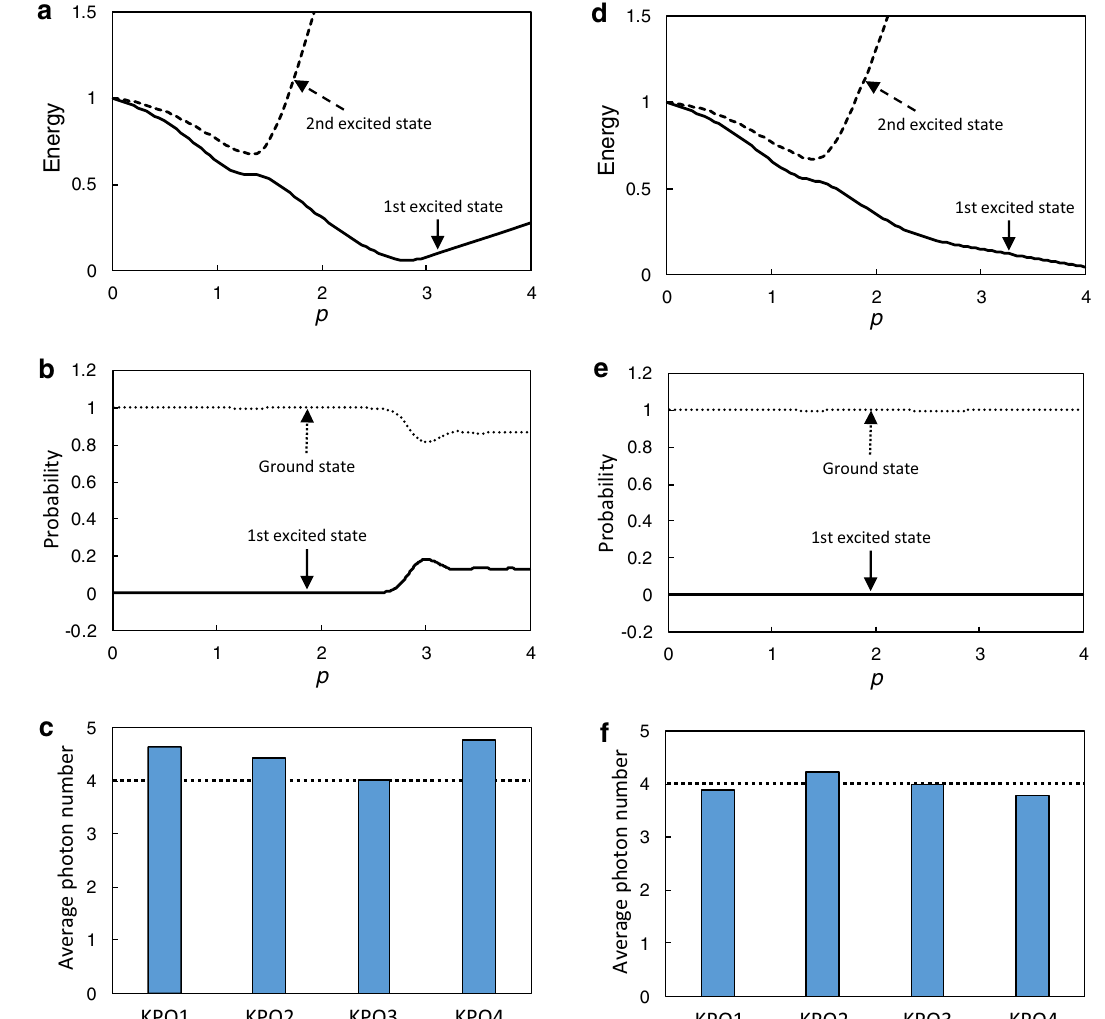
Fig. 5 Characterization of the worst instance of the proposed approach based on excited-state quantum annealing. The instance is indicated by a red vertical arrow in Fig. 1b. a Energy level of the fi rst (solid line) and second (dashed line) excited states from the ground level as a function of pump amplitude p in ground-state quantum annealing (QA) with a network of Kerr-nonlinear parametric oscillators (KPOs). (The reduced Planck constant and the Kerr coef fi cient are set as ℏ = 1 and K = 1, respectively.) b Time evolution of the population of ground (dotted line) and fi rst excited (solid line) states in the ground-state QA. c Final average photon number in each KPO in the ground-state QA. The horizontal dotted line in c indicates our design value 4. d – f Results corresponding to a – c , respectively, when the same instance is solved by ground-state QA with control of individual pump amplitudes to reduce photon-number